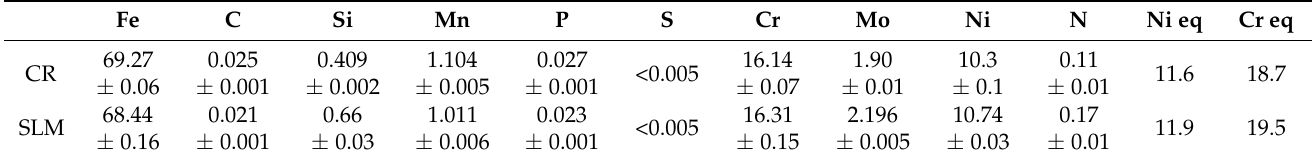
Figure 1. ( a ) Experimental welding setup. ( b ) Standard geometrical specifications described in EN ISO 6947. The composition of both CR and SLM sheets was measured by a foundry master spark OES spectrometer (Oxford), and the results (average and standard deviations of three measurements) are listed in Table 2. The composition of both is similar; however, one can mention the slightly higher amount of Si and Mo in the SLM samples. From these compositions, the Ni and Cr equivalent composition was calculated, and the result is plot- ted in Table 2 [35]. While plotting this equivalent composition on a Schaeffler diagram, between 5% and 10% of ferrite was expected. Table 2. Material composition (weight percent) and Ni and Cr equivalent according to the Schaeffler formula. Fe